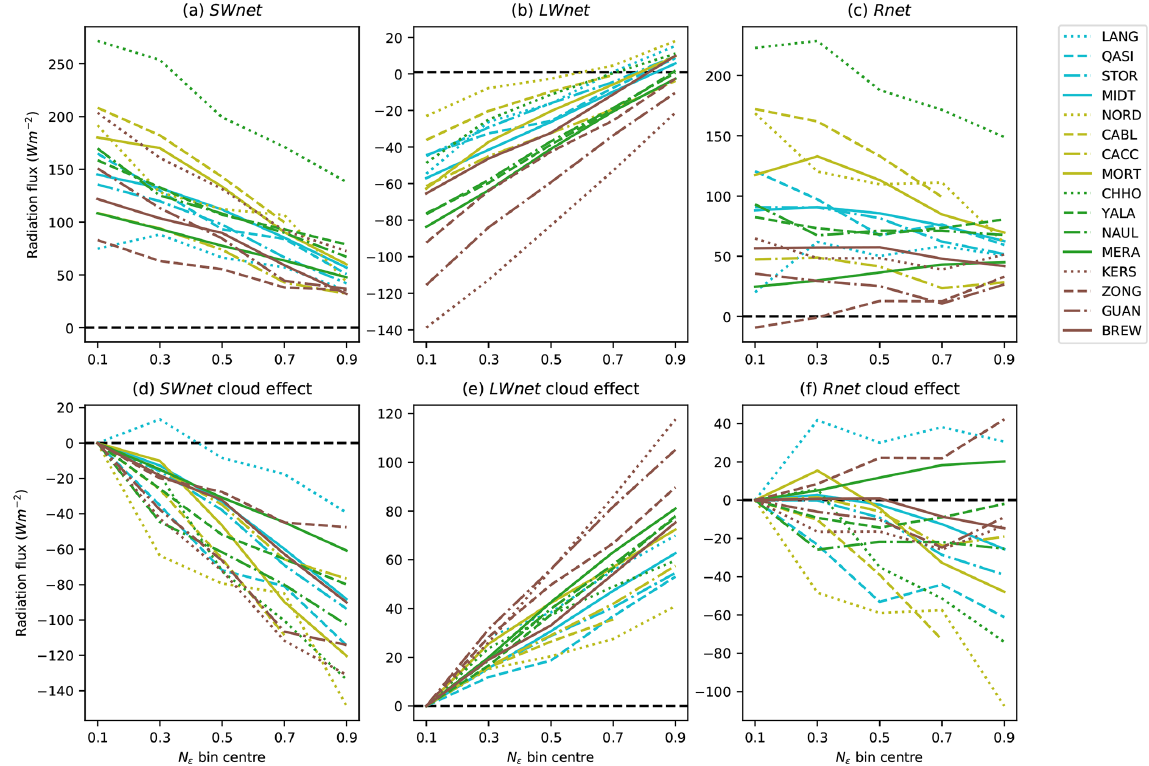
Figure 7. (a–c) Average melt-season net radiation fluxes (SWnet, LWnet, Rnet) for different daily average cloud conditions ( N ε ). (d–f) As for (a–c) expressed as change from clear-sky conditions ( N ε (cid:53) 0 . 2). Note that the y -axis range differs between panels.